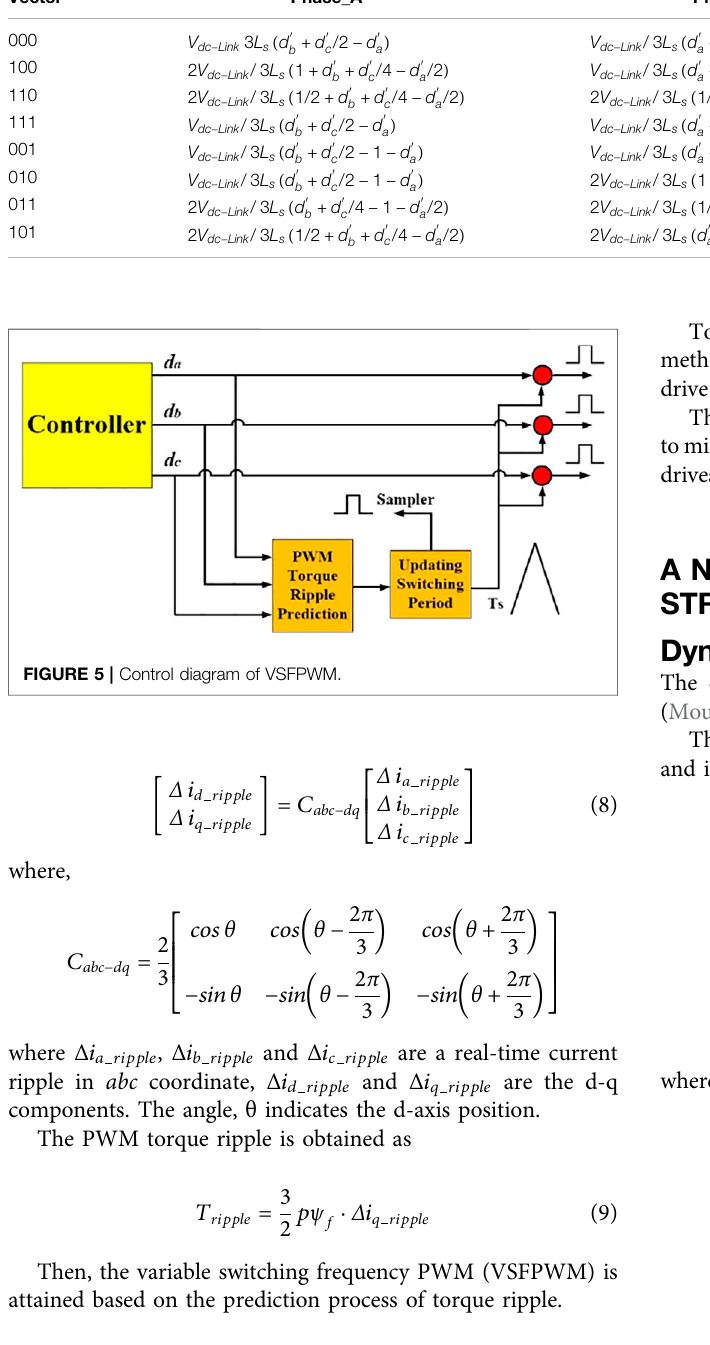
TABLE 1 | Slope of current ripple for the three phases (Hussien et al., 2020) . Vector